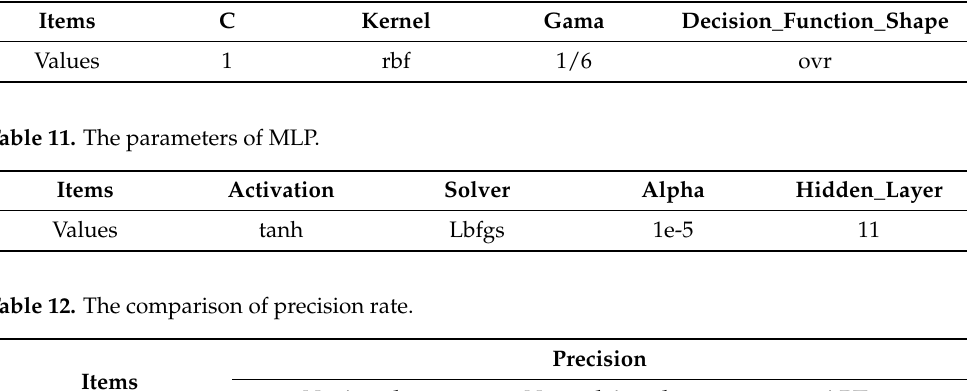
Table 10. The parameters of SVM.